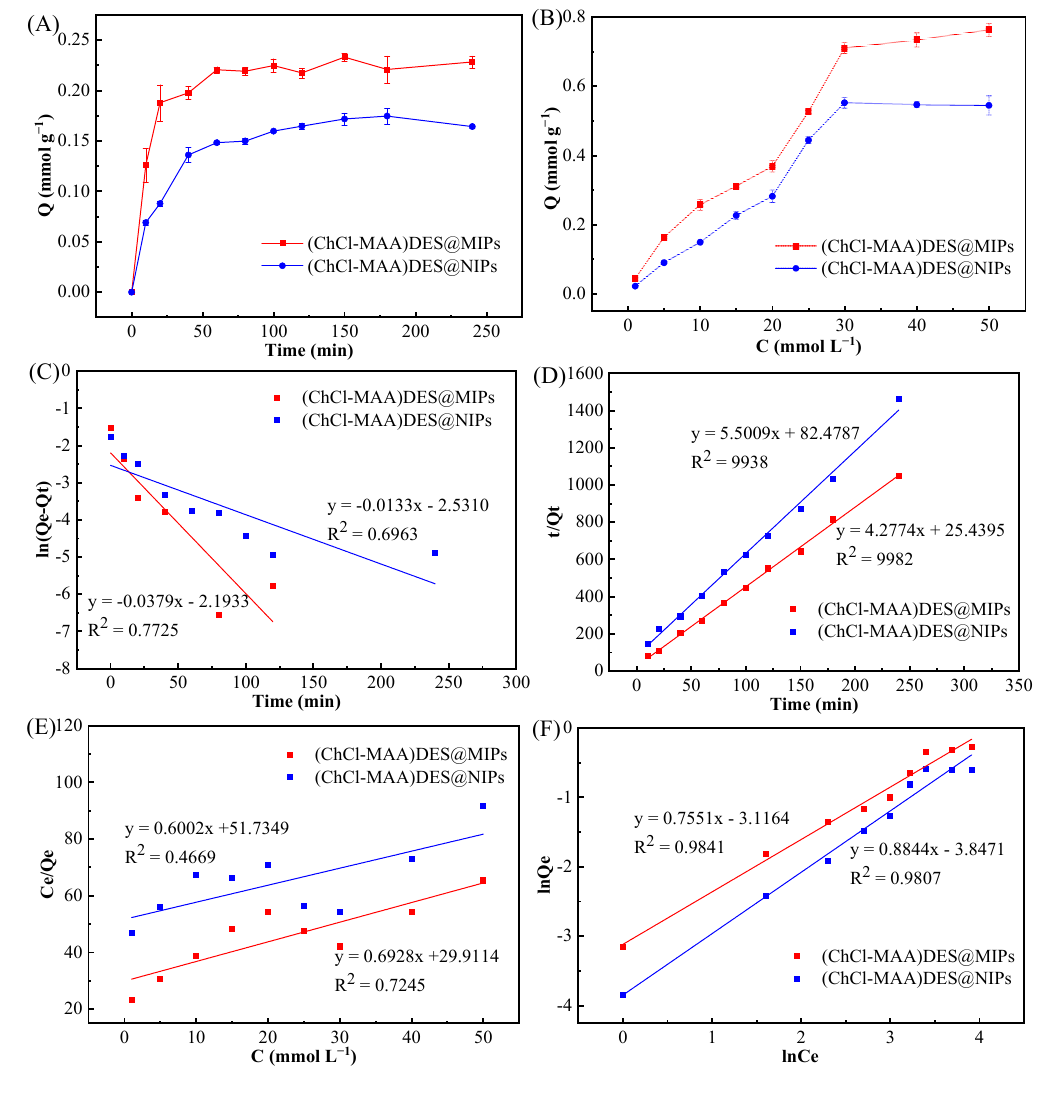
Figure 7. Adsorption kinetics curves ( A ), adsorption isotherms curves ( B ), pseudo-first-order kinetic model ( C ), pseudo-second-order kinetic model ( D ), Langmuir adsorption model ( E ), and Freundlich adsorption model ( F ) of GA on (ChCl-MAA)DES@MIPs or (ChCl-MAA)DES@NIPs. Table 2. Simulation parameters of pseudo-first-order and pseudo-second-order kinetic equations at 298